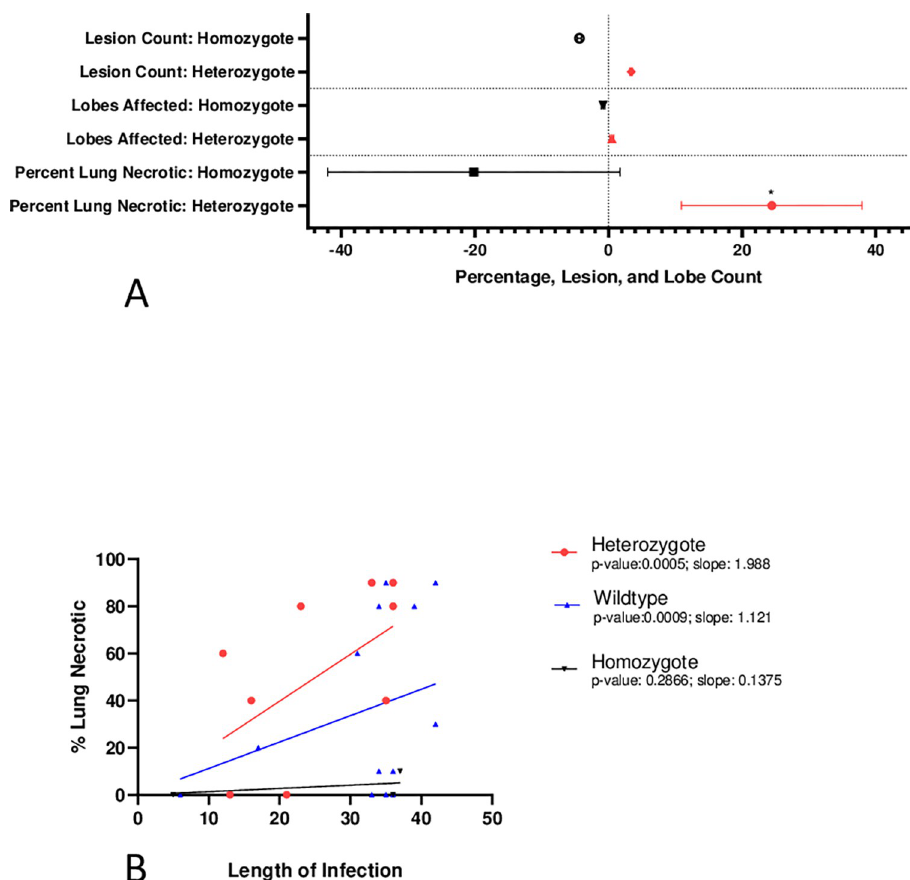
Fig 3. Genotypic Variance of Pathological Progression A. SNP 3195 Genotypes Compared to Wildtype: representation of general linear model values and SEM, showing the SNP3195 homozygote and the SNP3195 heterozygote compared to the wildtype in terms of lesion count within the lungs, lobes affected, and the percent of lung necrotic. � p-value = 0.0585 comparing homozygote and heterozygote percent lung necrotic. B. Percentage of Lung Necrotic by Genotype; SNP 3195: Simple linear regressions showing the correlation in the percentage of lung necrotic and the length of infection, accounting for genotype.